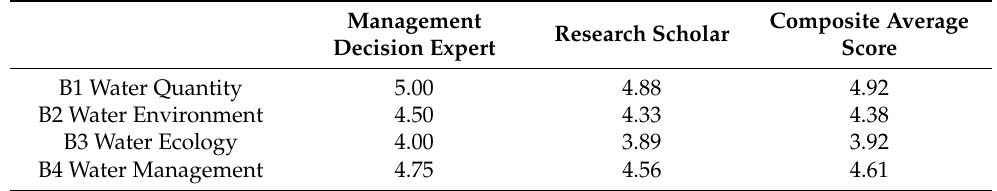
Table A2. Average scoring results of experts in water quantity, water environment, water ecology, and water